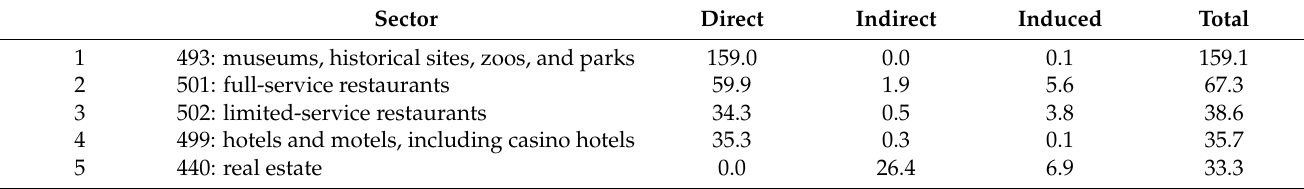
Table A13. Top Five Affected Sectors by